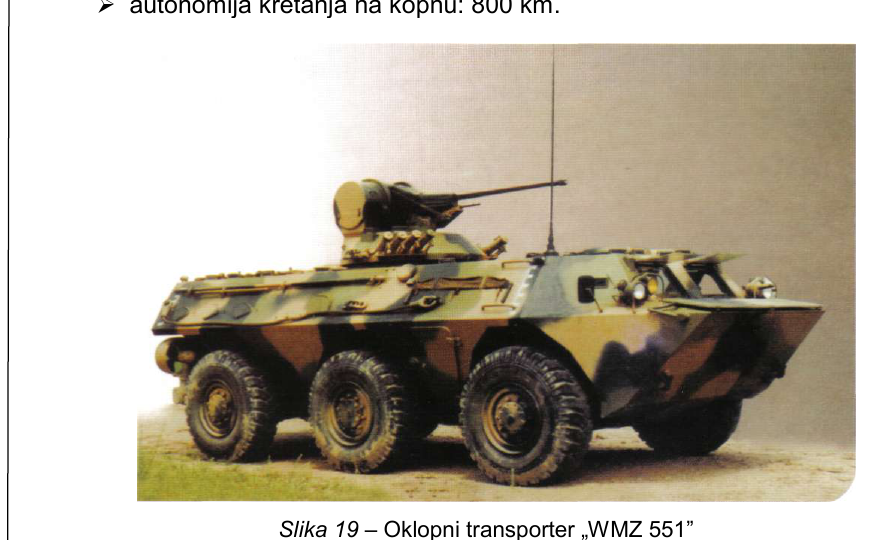
Figure 19 – Armoured personnel carrier